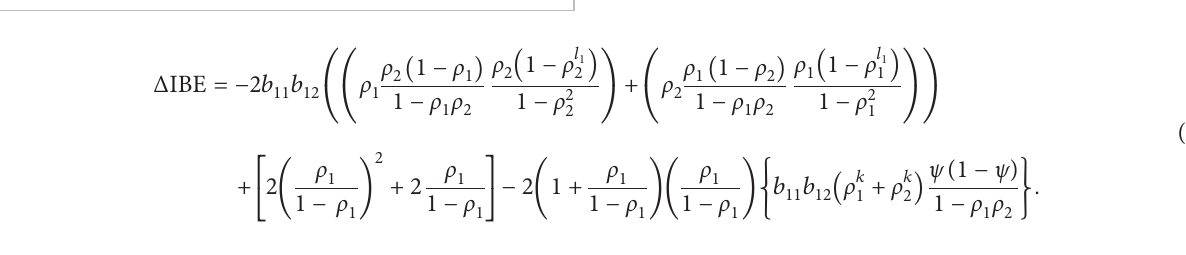
and ρ on the bullwhip effect using different forecasting 1 2